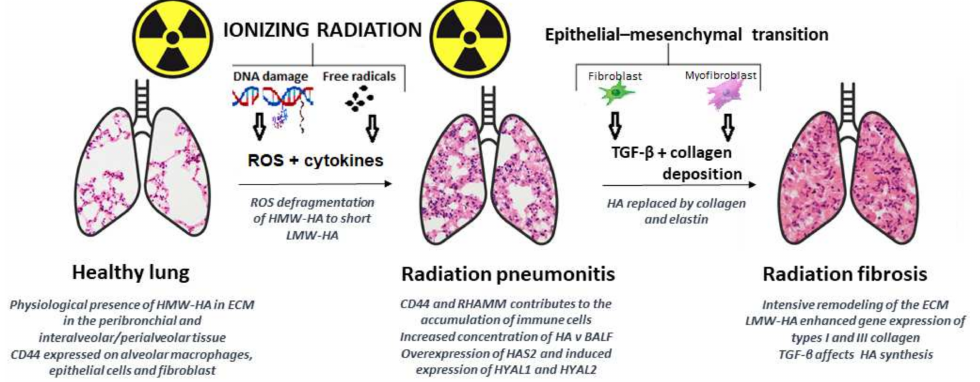
Figure 3. Radiation induces lung injury and hyaluronic acid. The mechanism of radiation pneu- monitis is initiated by ionizing radiation, which causes extensive DNA damage and large-scale production of free radicals in lung tissue. Both processes trigger persistent inflammation with all consequences leading to pathological changes, including immune cell infiltration, capillary perme- ability, and pulmonary edema. Untreated pneumonitis leads to serious radiation damage of the lungs, which causes irreversible radiation fibrosis characterized by an accumulation of extracellular matrix proteins. Hyaluronic acid, protein in its metabolism, and HA-binding proteins are significantly affected by ionizing radiation in lung tissue and have a distinct impact on RIPI